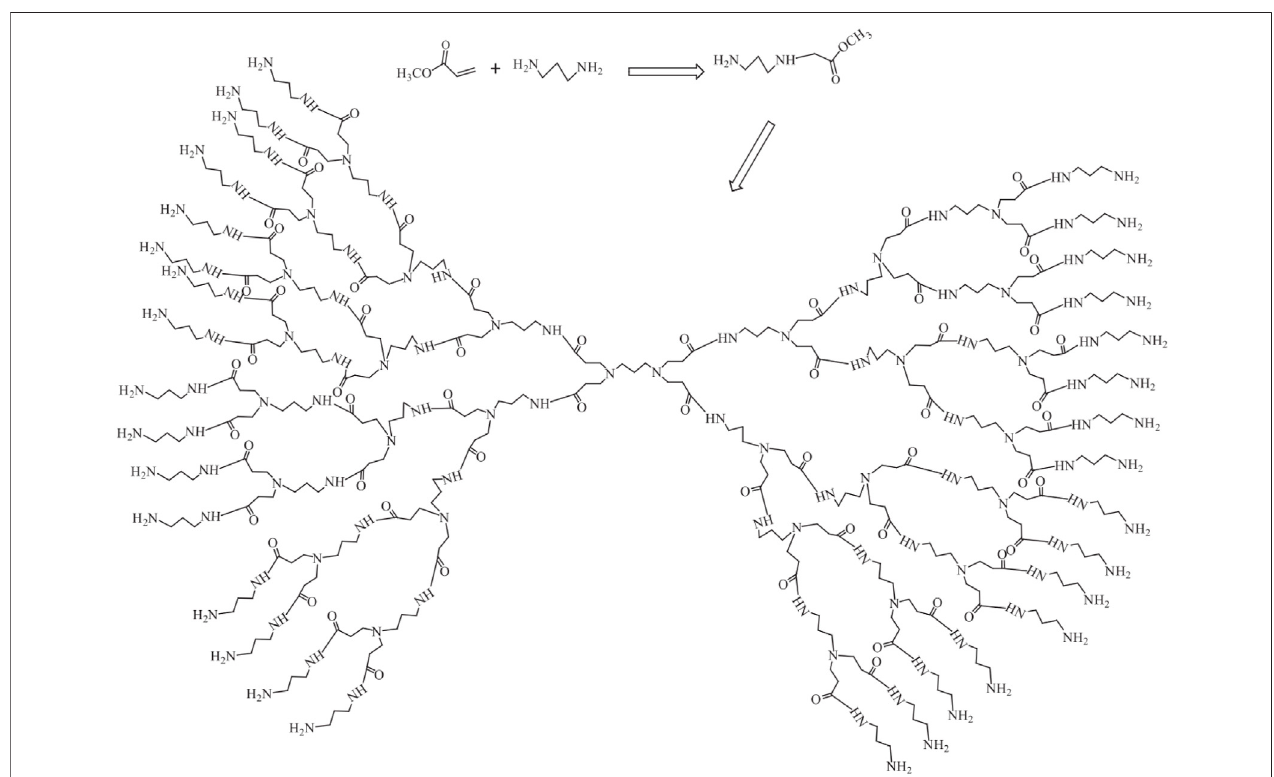
FIGURE 13 | Synthesis route of H-PAMAM (Zhang et al.,